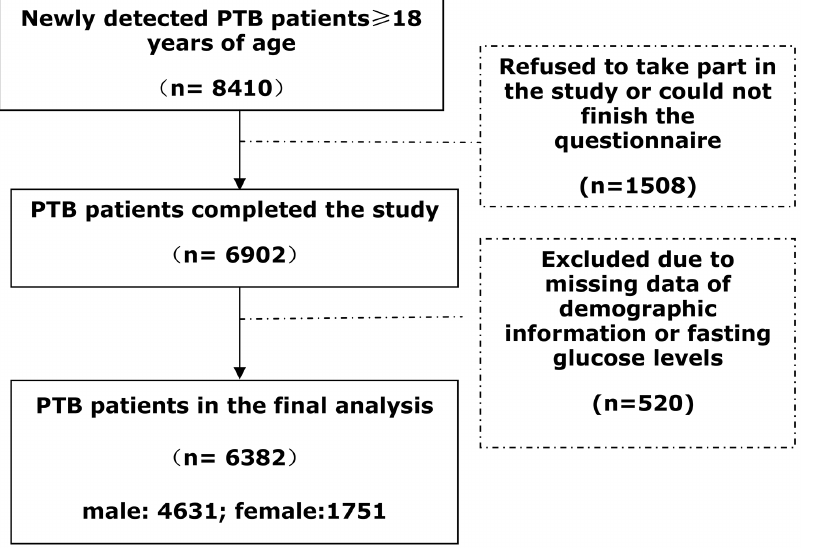
Figure 1. Flowchart of the pulmonary tuberculosis patients in the study, Linyi, 2010–2012. The details on the total number of eligible participants, those who have given written consent to undergo screening of DM and the patients included in the final analysis are illustrated in Figure 1. There were 8410 newly detected pulmonary tuberculosis patients in total study period. Finally, 6382 patients were included in the final analysis.